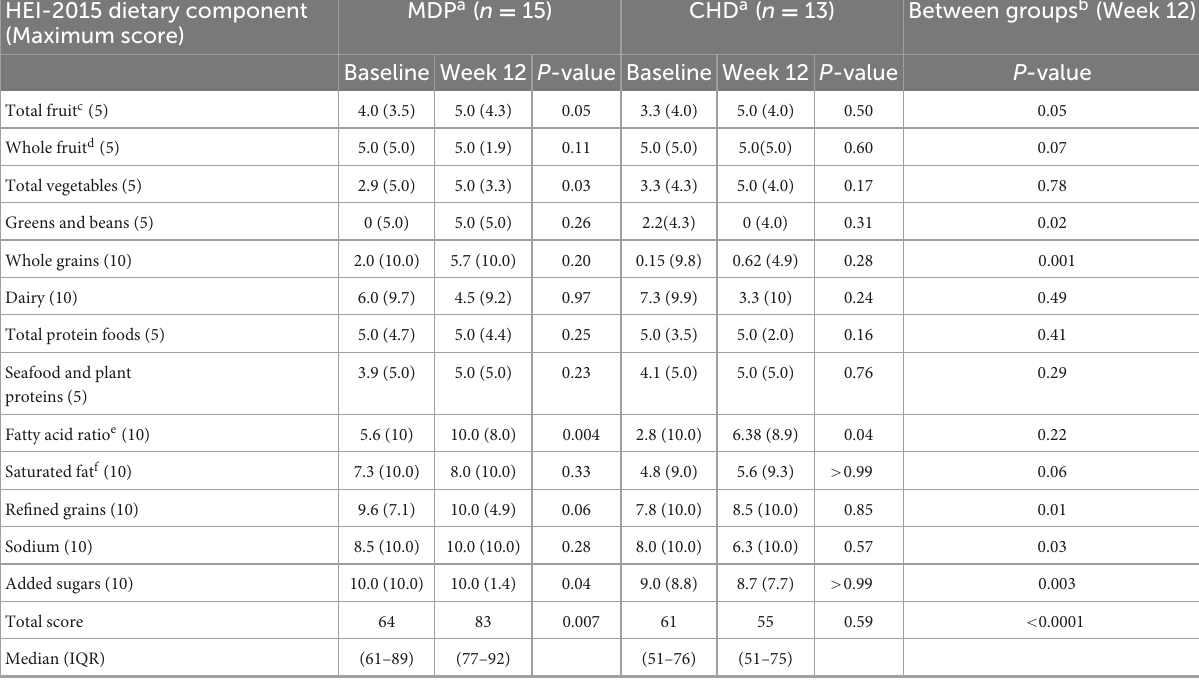
TABLE 5 Median HEI-2015 component scores for the Mediterranean diet pattern and Canadian habitual diet pattern at baseline and week 12, with higher scores reflective of better diet quality. HEI-2015 dietary component MDP a ( n = 15) (Maximum score)